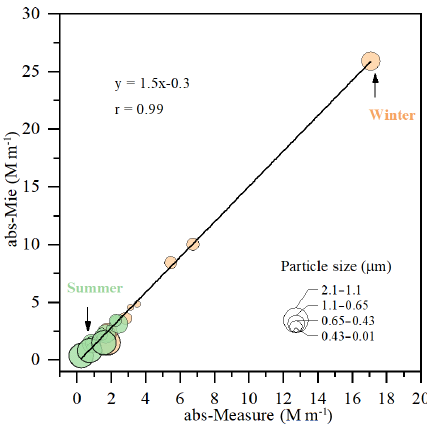
Figure 4. An orthogonal regression analysis for abs λ = 365nm be- tween samples predicted by Mie theory and extracted by water for different particle sizes ( D p <2.1µm).